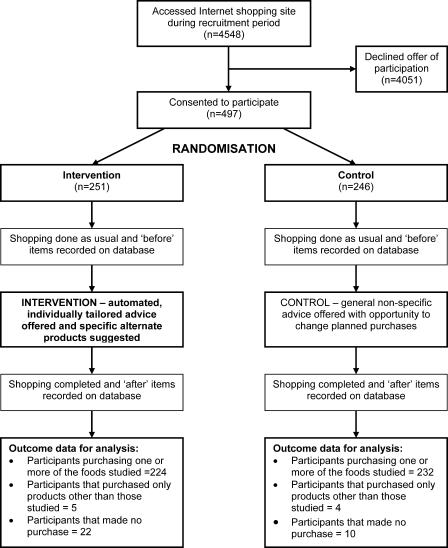
Flow Chart of Study